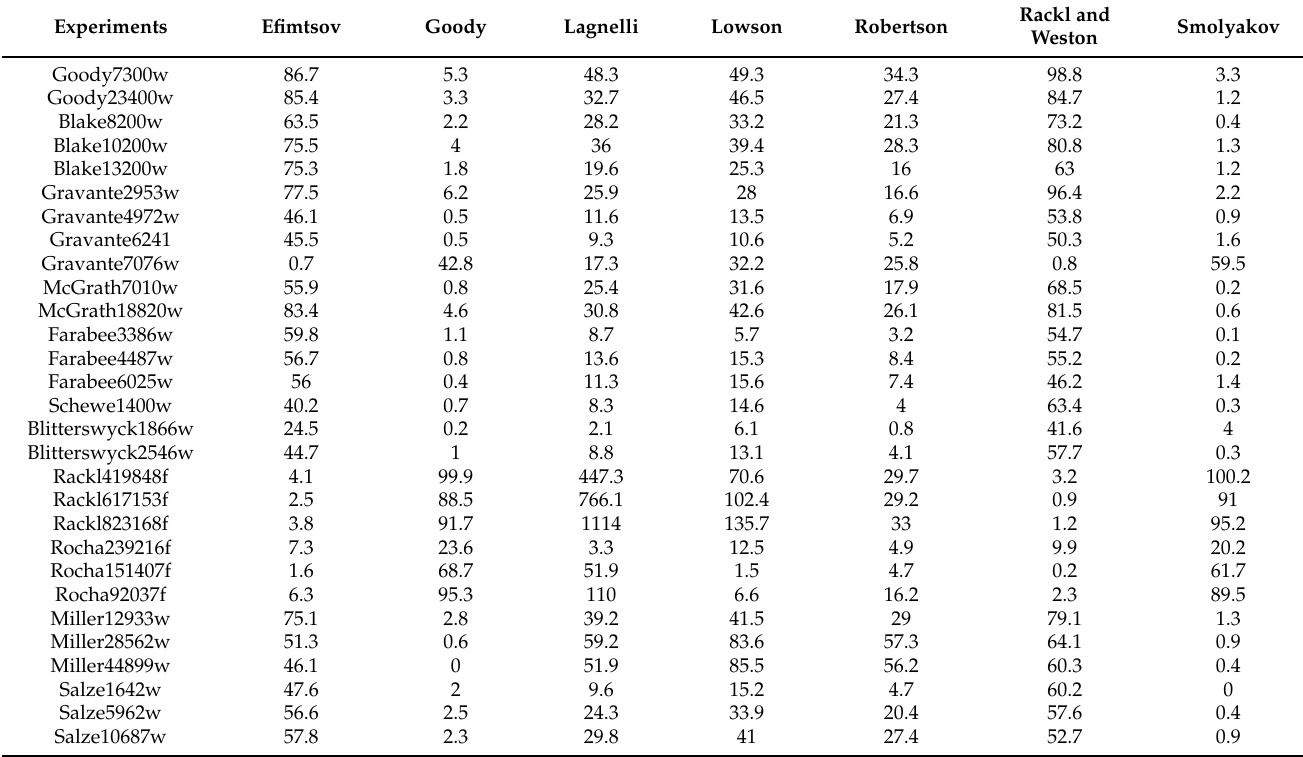
Table A6. Spectrum mean squared error for the overlap frequency range.